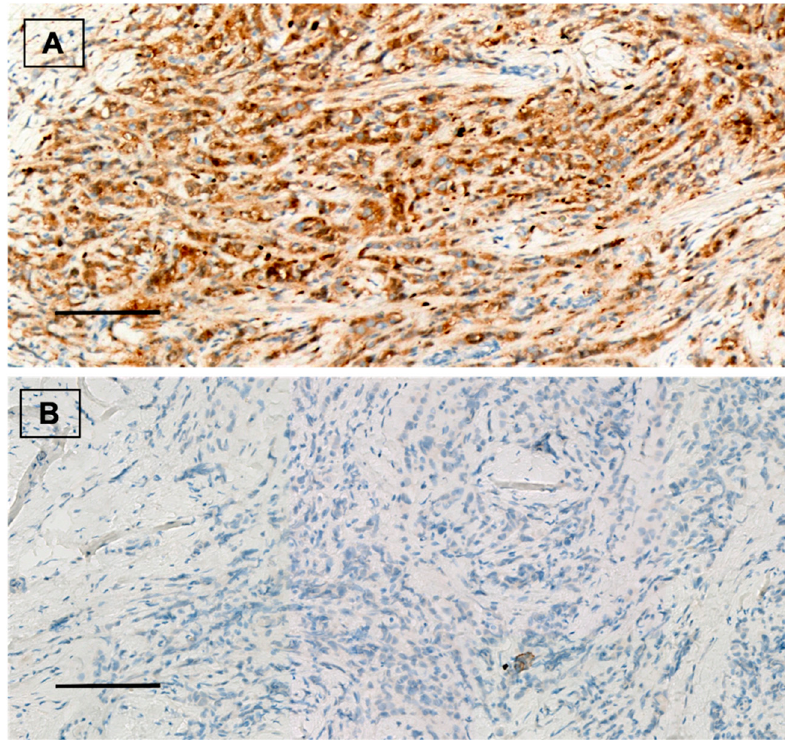
Figure 1. ( A ) ALDH1A1 positive staining in breast carcinoma. Immunohistochemical staining for ALDH1A1 (brown) with Mayer’s hematoxylin counterstain. ×20, scale bar = 100 µm. ( B ) ALDH1A1 negative control. ×20, scale bar = 100 µm.